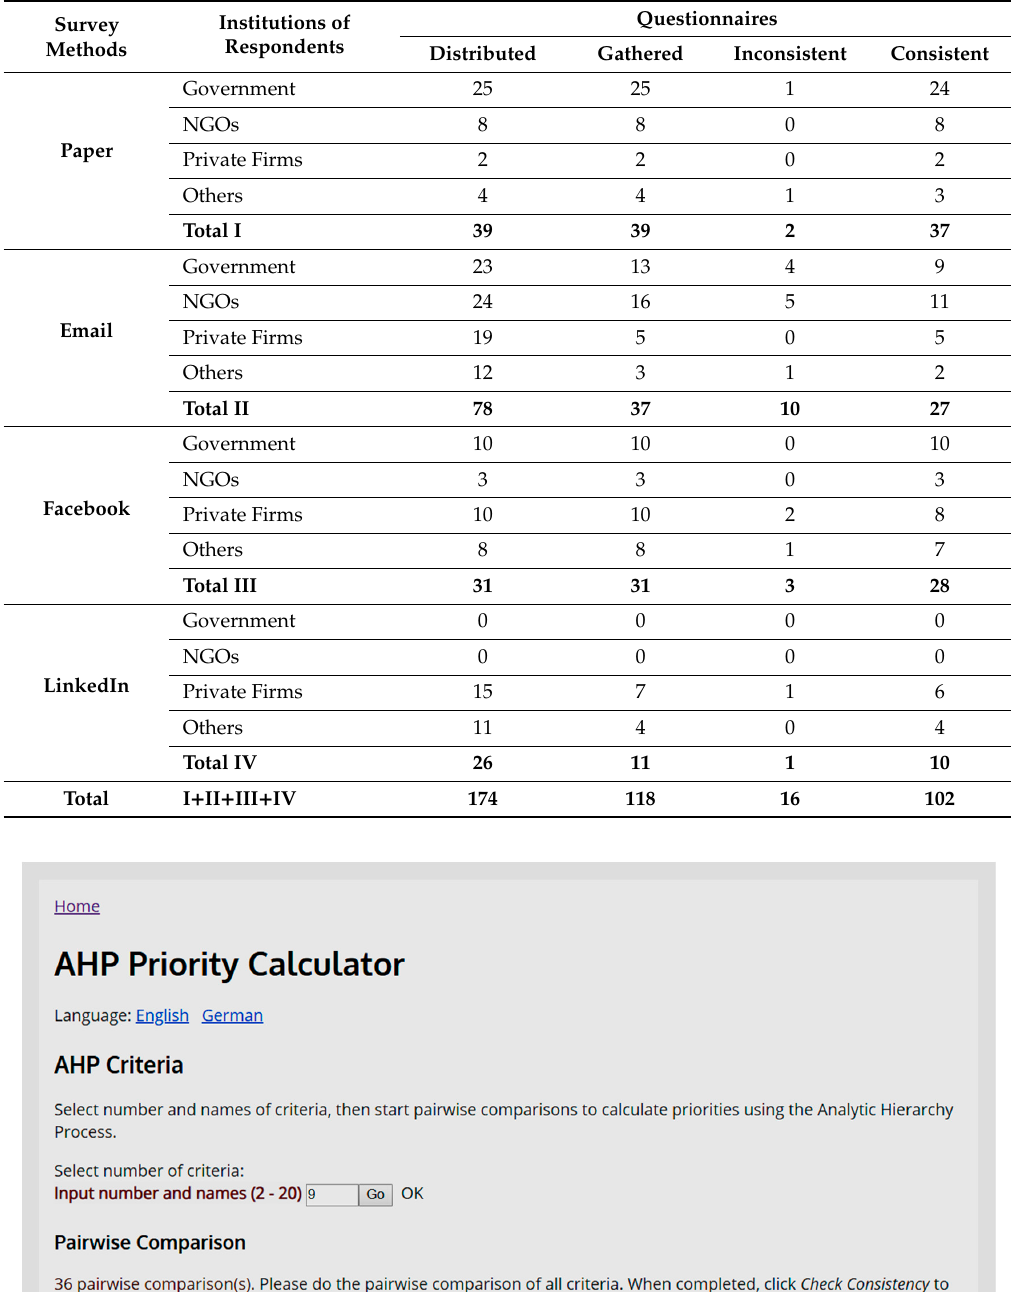
Table 2. Statistics of the survey.